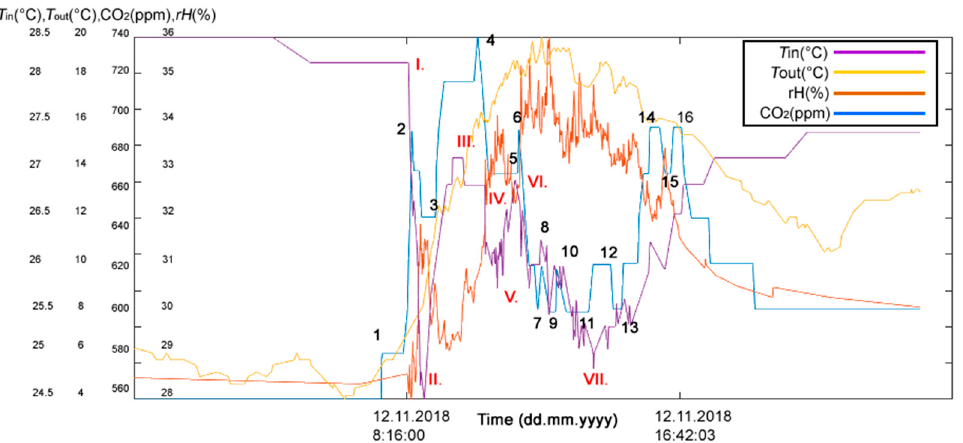
Figure 6. The reference (measured) CO 2 concentration course, indoor temperature and relative humidity course (12 November 2018), in room R203, outdoor temperature course (12 November 2018) within the measurement of nonelectrical values in SHC for ADL monitoring. (1) arrival (12 November